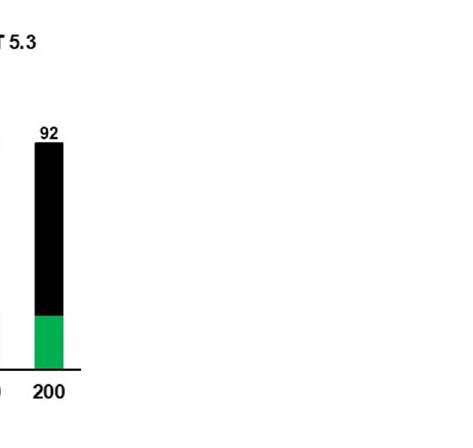
Figure 8. Significant negative correlation ( p < 0.01) between peak area of RT 5.3 (New peak) and RT 7.3 (Thymoquinone).